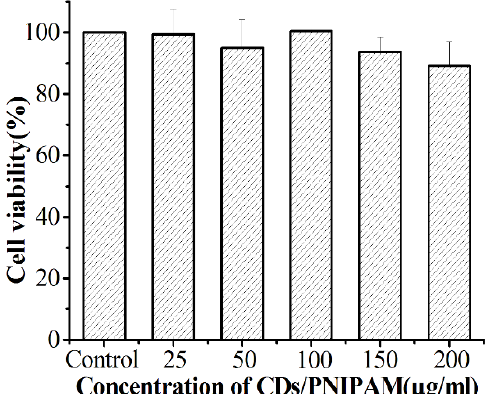
Figure 11. Cell viability of CDs/PNIPAM incubated with L02 cell for 24 h.